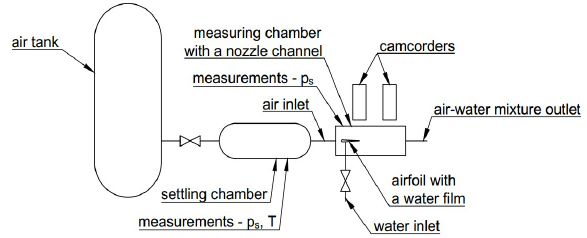
Figure 3. Measurement schema of the